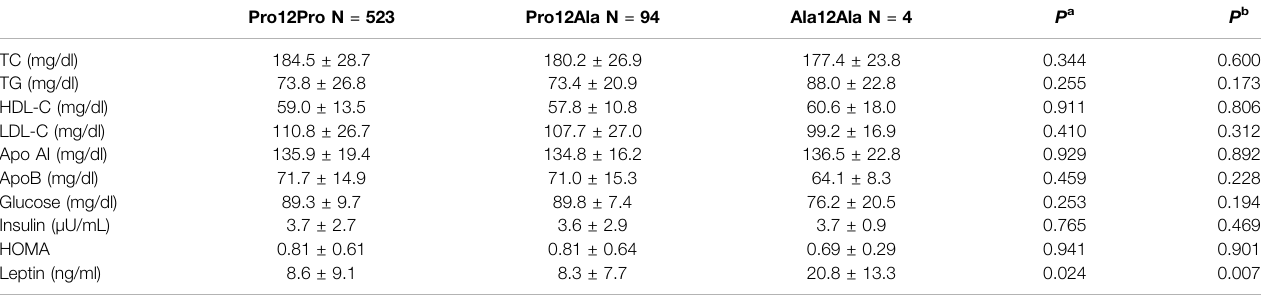
TABLE 5 | Biochemical variables (mean ± SD) according to the PPAR γ 2 Pro12Ala genotype in females.